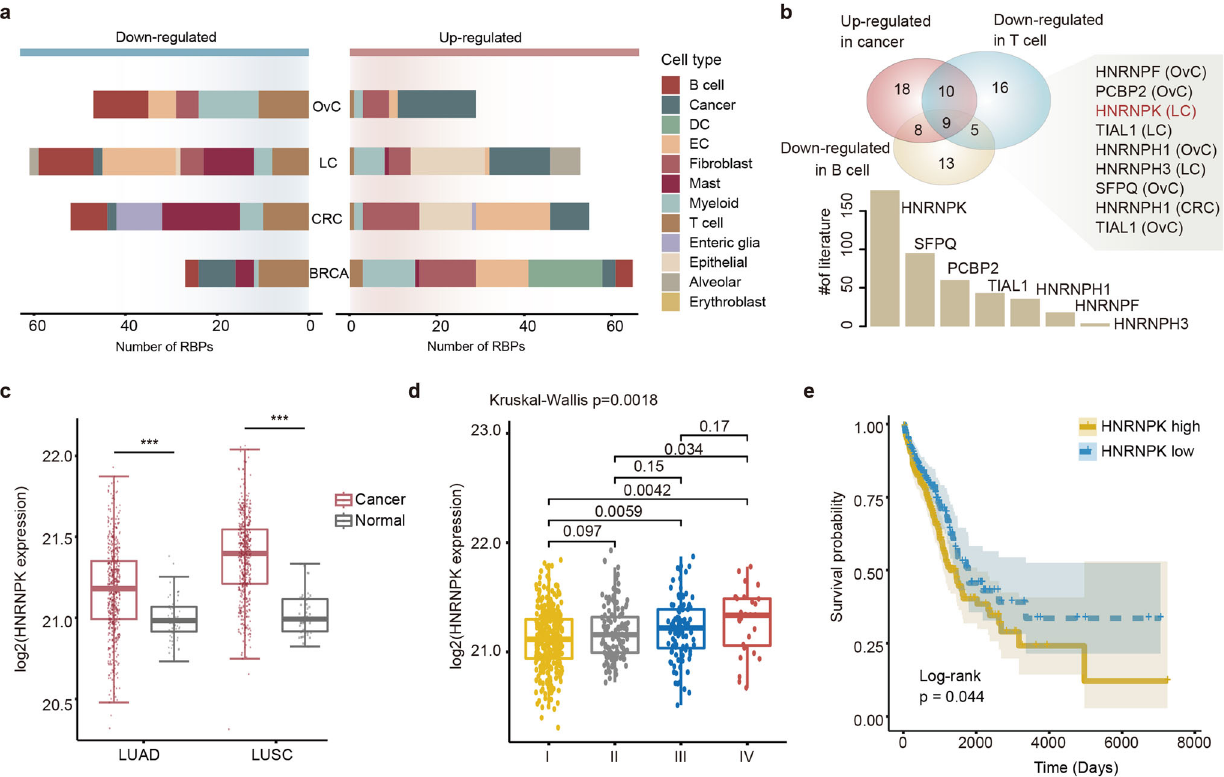
Fig. 3 Prioritization of oncogenic RBP regulator HNRNPK in lung cancer. a Numbers of differentially expressed RBP regulators in different cell types across cancers. Left for downregulated and right for upregulated RBP regulators. b The top panel showing the overlap of RBPs upregulated in cancer and downregulated in immune cells. The comparison was performed by cancer type. The aberrations of cancer types indicated in brackets were the cancers in which the RBP regulator was identi fi ed. The bottom bar plots showing the number of literatures for RBP regulators. c Boxplots showing the expressions of HNRNPK in LUAD and LUSC. *** p < 0.001 for Wilcoxon ’ s rank sum tests. Error bars showing the fi rst and third quantiles. d Boxplots showing the expressions of lung cancer patients with different stages. Error bars showing the fi rst and third quantiles. Comparison among groups was by Kruskal – Wallis test and between two groups by Wilcoxon ’ s rank sum tests. e Kaplan – Meier survival analysis of lung cancer patients (LUAD) strati fi ed by the median expression levels of